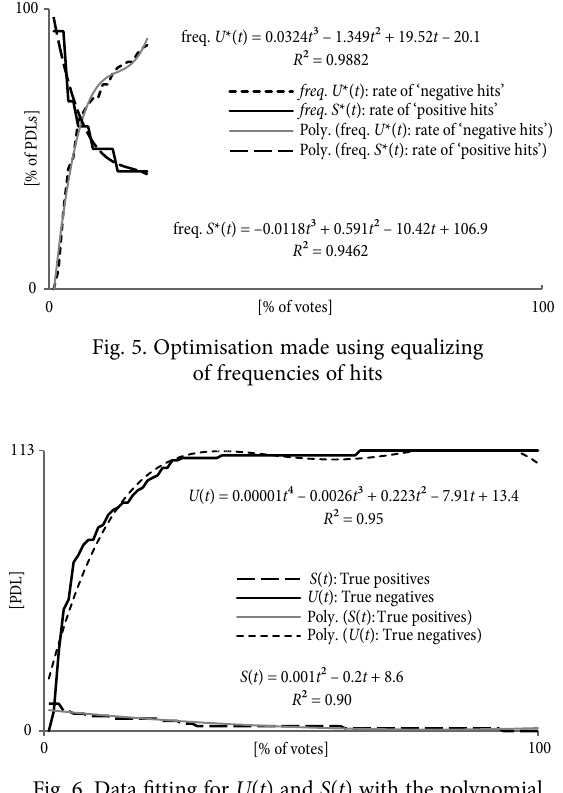
Fig. 6. Data fitting for U ( t ) and S ( t ) with the polynomial regression lines